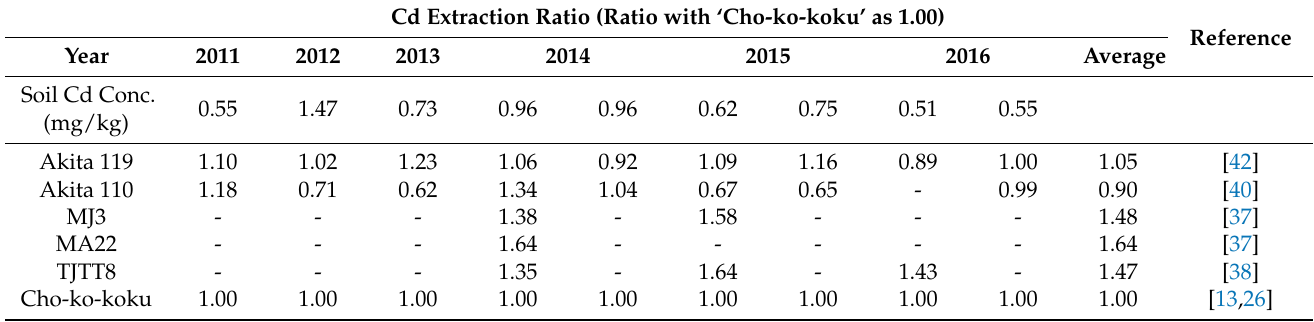
‘Cho-ko-koku’ on average, although some cultivating problems of these lines, such as late heading and maturing date, were revealed in northern parts of Japan. Table 2. Cd extraction ratio. Each variety or line was cultivated in Cd contaminated field in Akita Prefecture. The ratio is calculated by the Cd extraction of ‘Cho-ko-koku’ cultivated in the same field as 1.00. “-” indicates no data. Cd Extraction Ratio (Ratio with ‘Cho-ko-koku’ as 1.00)